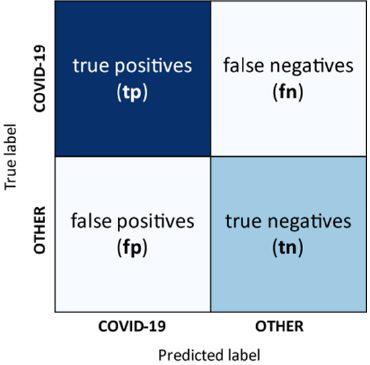
Figure 4. Confusion matrix example.